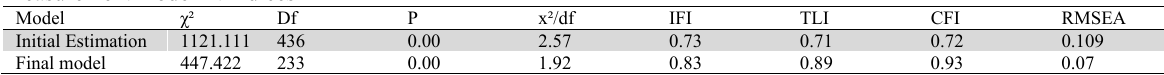
Measurement model fit indices